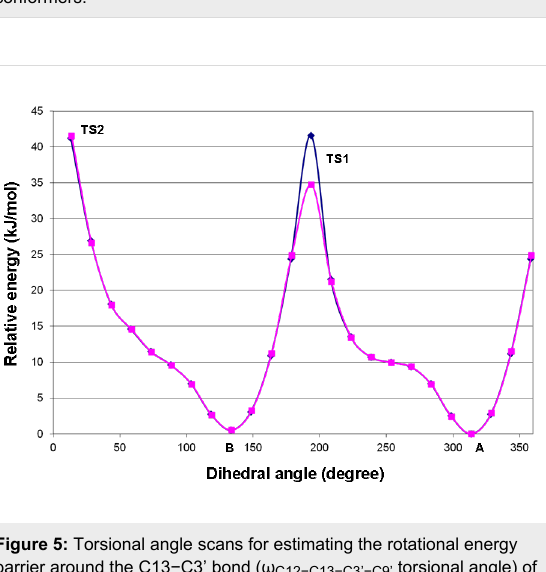
Figure 5: Torsional angle scans for estimating the rotational energy barrier around the C13 − C3’ bond ( ω C12 − C13 − C3’ − C9’ torsional angle) of (2 R ,3 R )- 1 . The scans were started from the lowest-energy in vacuo conformers with M and P helicity (conformer A and B, respectively). The relative energy (kJ/mol) is plotted as the function of the ω C12 − C13 − C3’ − C9 torsional angle. TS1 and TS2 denote the two transi- tion states for the inversion of the helicity.